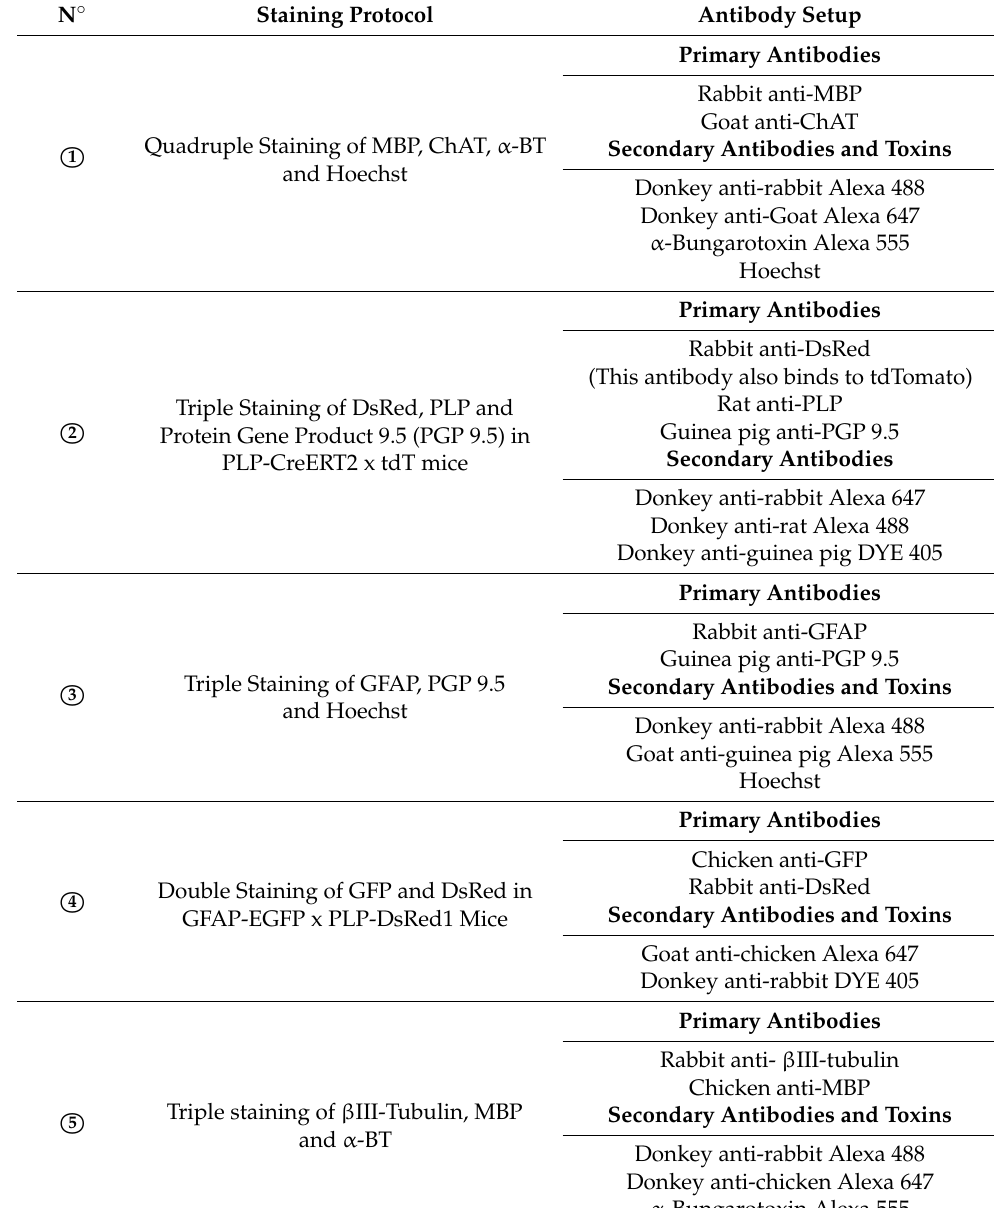
Table 2. Synopsis of applied staining protocols for whole mounts including each antibody